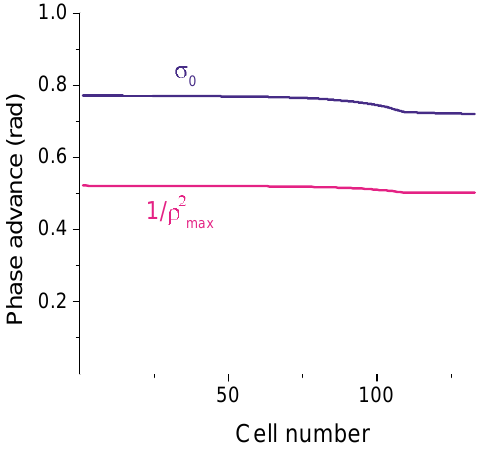
FIG. 4. (Color) Phase advance s 0 and minimum normalized transverse frequency 1 (cid:2) r 2 max along the